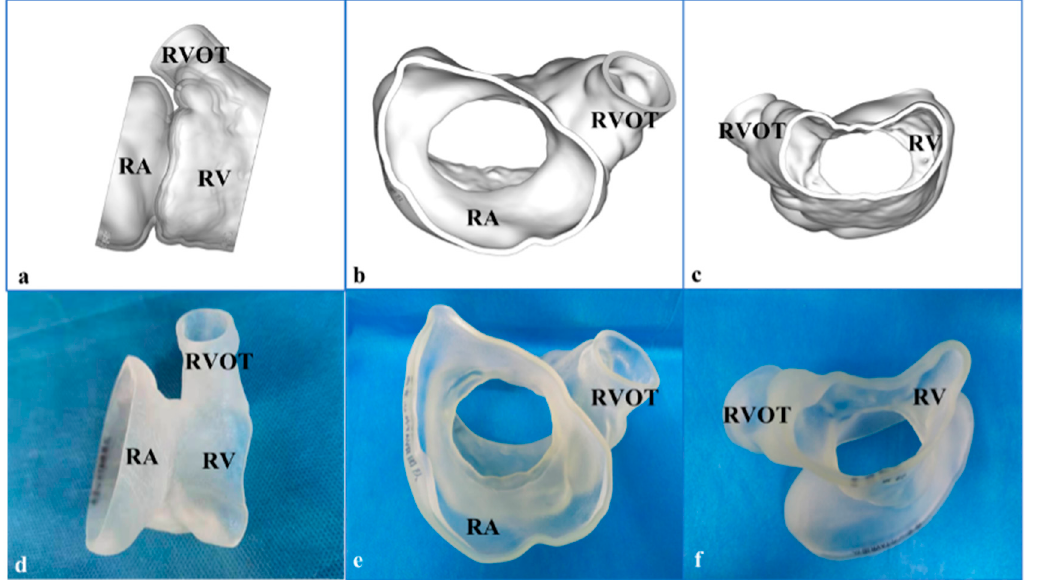
Figure 3. The 3-dimensional (3D)-printed model reconstructed by computed tomography angi- ography for preprocedural planning and simulation. ( a ) Three-dimensional reconstruction image from the lateral view. ( b ) Three-dimensional reconstruction image from the right atrial (RA) view. ( c ) Three-dimensional reconstruction image from the right ventricular (RV) view. ( d ) The 3D-printed model from the lateral view. ( e ) The model from RA view. ( f ) The model from the RV view. CTA: computed tomography angiography; RA: right atrial; RV: right ventricle; RVOT: right ventricular outflow tract.